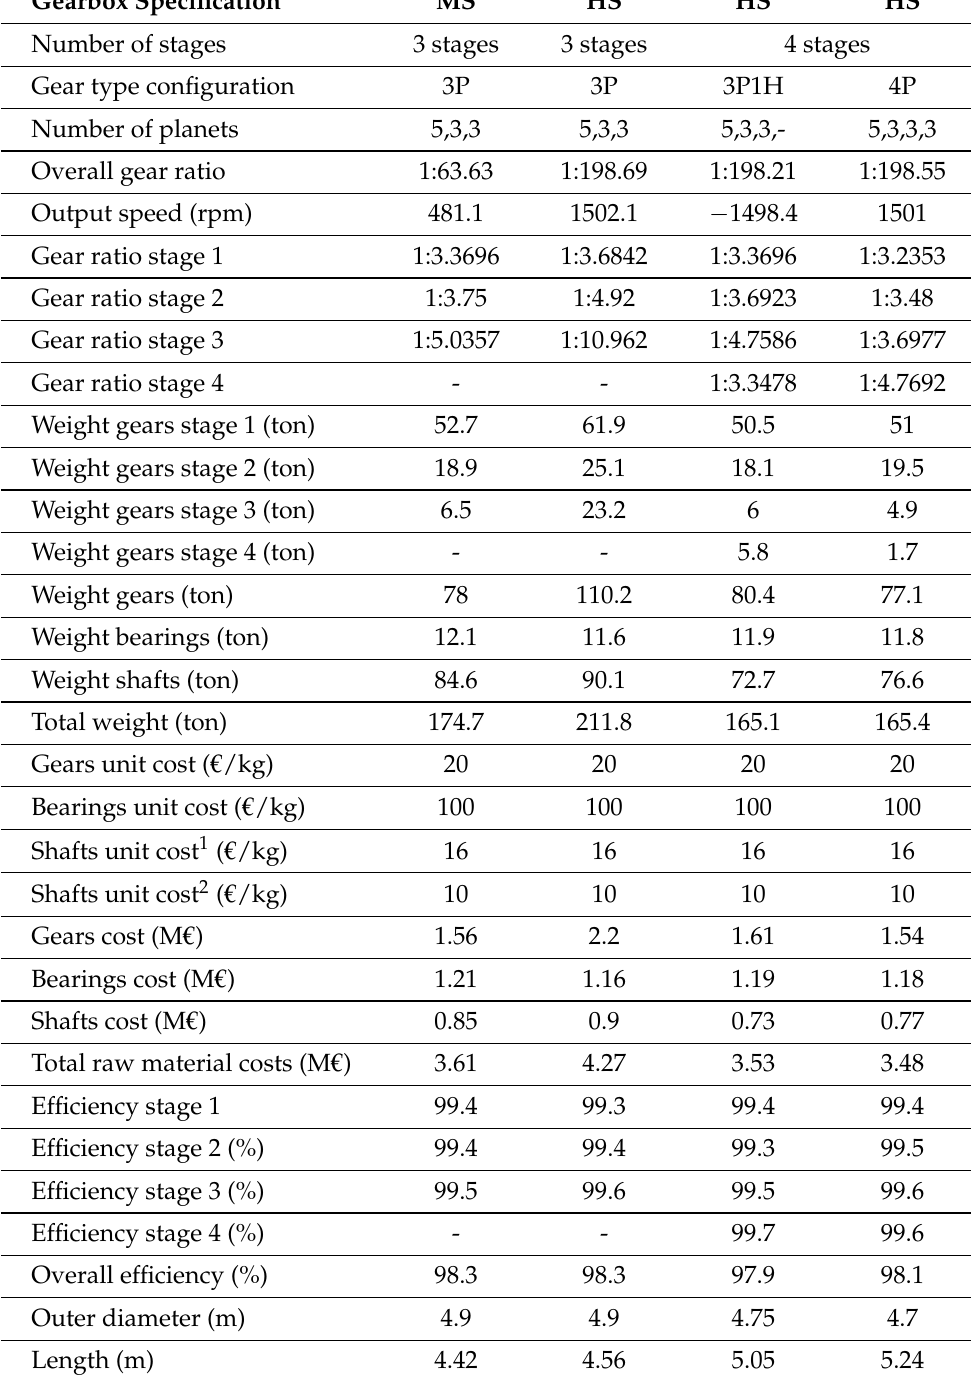
Table 9. Gearbox design